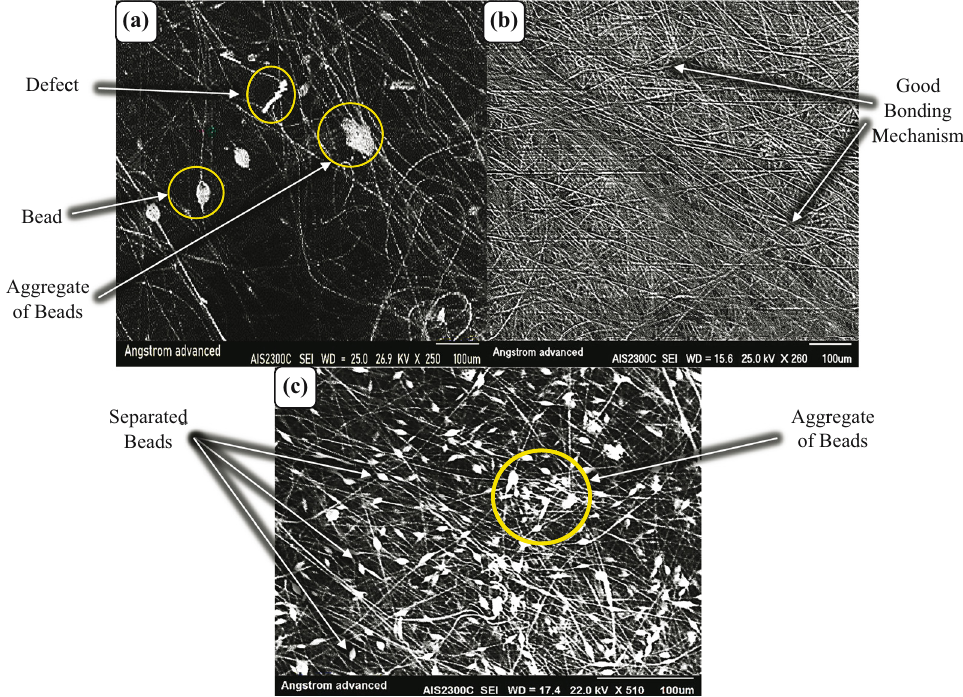
Figure 6: SEM image of the prepared specimens: ( a ) PS, ( b ) PS/ZrO 2 , and ( c )